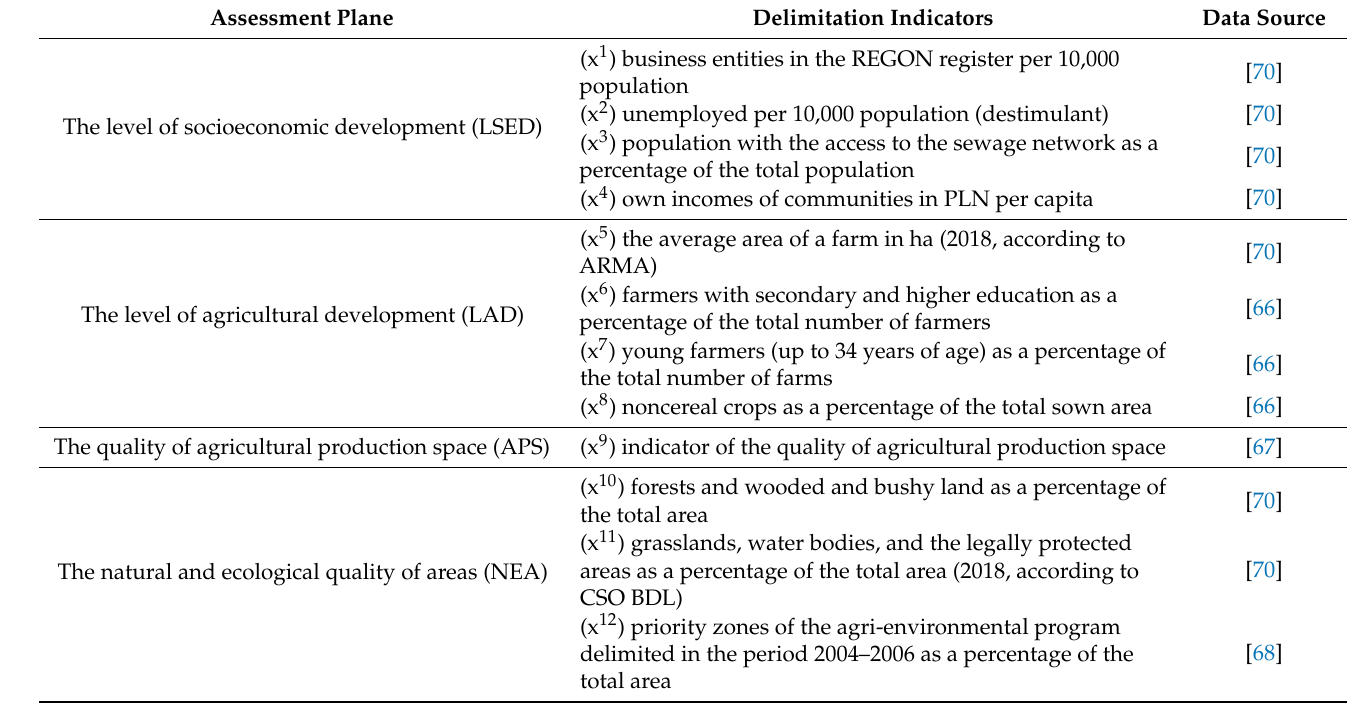
Table 1. Assessment planes—determinants of development of sustainable agriculture in Poland characteristics. Source: own elaboration on